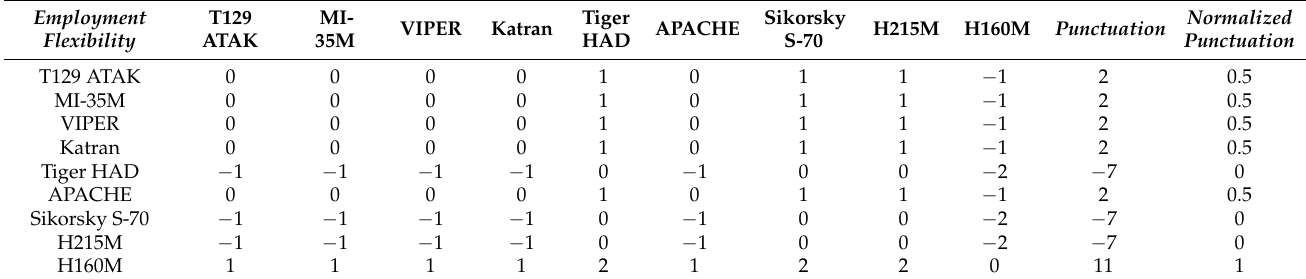
Table 10. Evaluation of alternatives under qualitative criterion Employment flexibility .